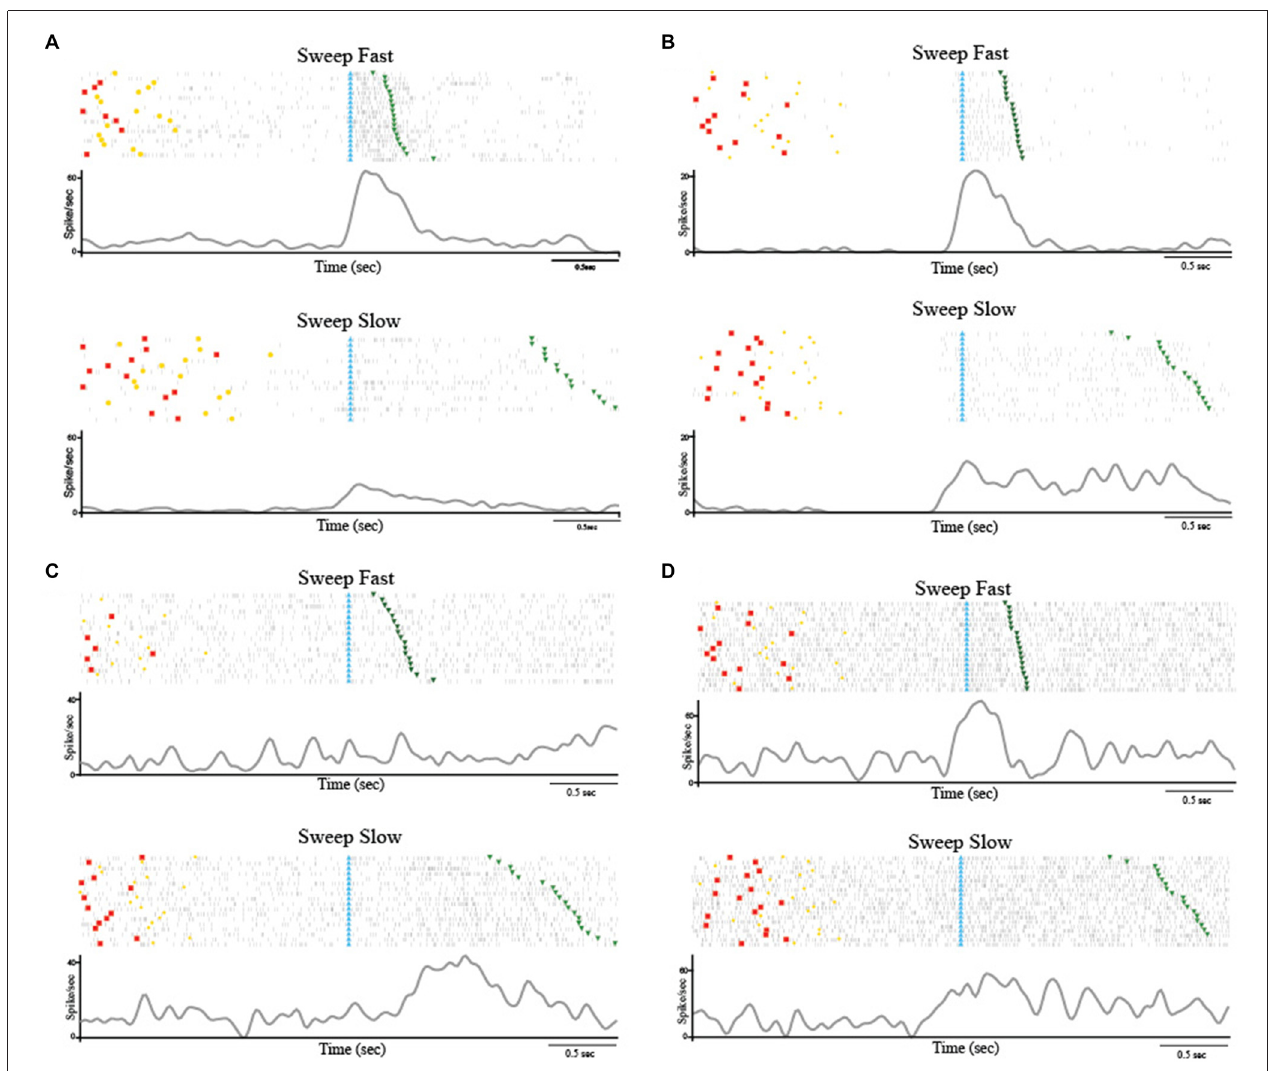
FIGURE 2 | (A) Example of speed selective (SS) neuron (Fast Selective). The neuron was only modulated during the Sweep Fast. The neuron was recorded in the right hemisphere and the receptive field (RF) was located on the hairy side of the bilateral hand. (B) Example of SS neuron (Fast Selective). The neuron was modulated during both sweeping velocities, but the activity during the Sweep Fast was higher than that during the Sweep Slow. The neuron was recorded in the right hemisphere and the RF was located on the hairy side of the bilateral hand. (C) Slow Selective neuron, activated only during the Sweep Slow. The neuron was recorded in the left hemisphere and the RF was located on the bilateral hairy side of the mouth. (D) Example of speed unselective (SU) neuron. The neuron was modulated during both sweeping speeds, independently of the velocity. The neuron was recorded in the right hemisphere and the RF was located on the bilateral hairy side of the hand. The stimulation was performed on the contralateral side, from the distal (fingers) to the proximal part (near wrist). In (A–D) the histograms are aligned at the starting point of the stimulation, indicated by the light blue triangles. The end of the stimulation is indicated by the green triangles. The time between the red dots and yellow circles indicates the baseline, while the time between the light blue and green triangles represents the stimulation epoch. The histograms are normalized for the maximal spike/s value between the two